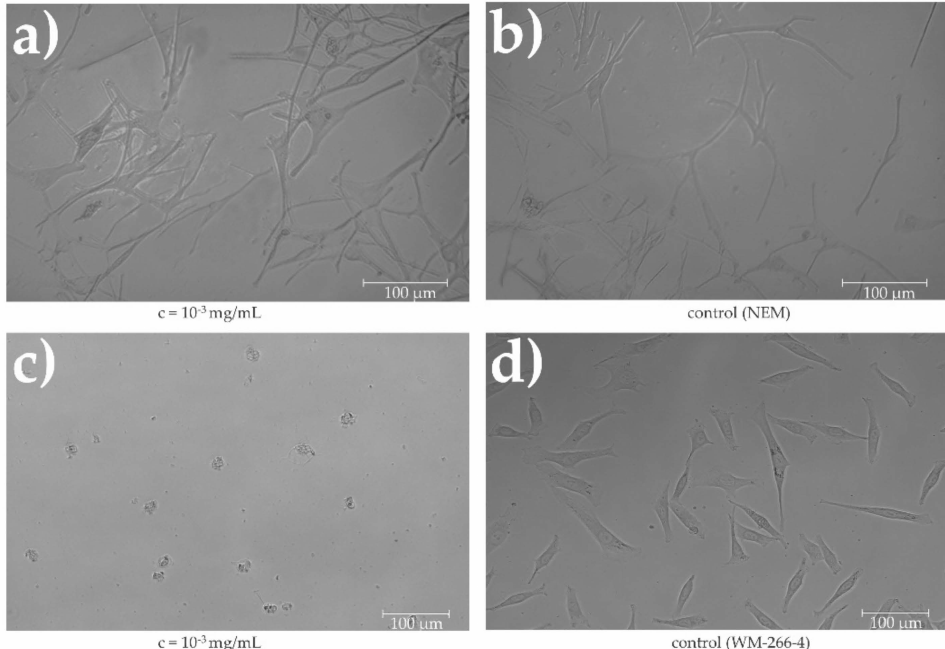
Figure 8. ( a ) Normal human epidermal melanocytes in medium; ( b ) normal human epidermal melanocytes with applied extract (10 3 mg/mL); ( c ) human melanoma cells WM-266-4; ( d ) human melanoma cells WM-266-4 with applied extract (10 − 3